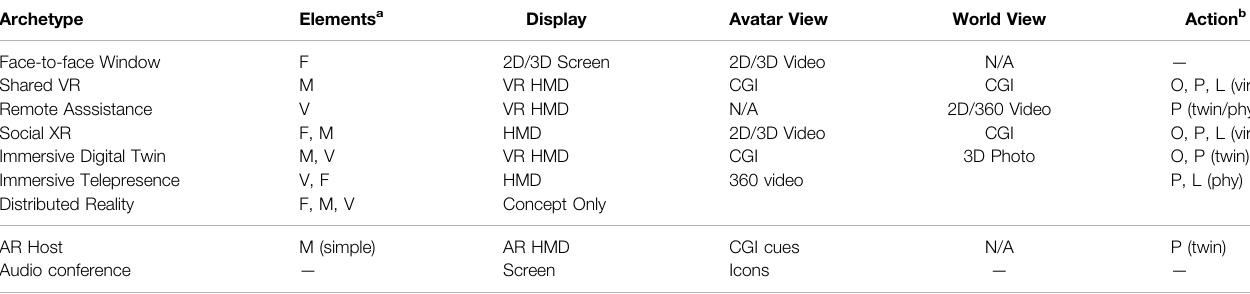
TABLE 2 | Implementation of the immersive communication system archetypes.